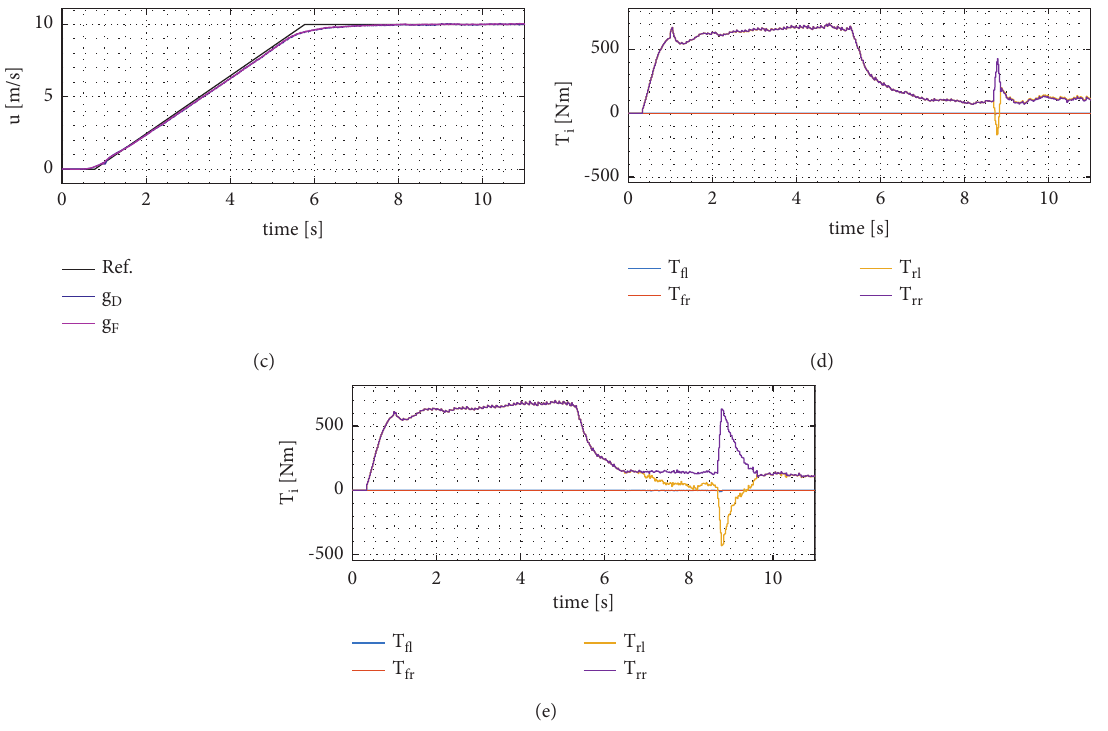
Figure 10: Comparison of the two cost functions in the inner loop. (a) Yaw rate. (b) Road-wheel angle. (c) Longitudinal velocity. (d) Wheel torques g . (e) Wheel torques g D F